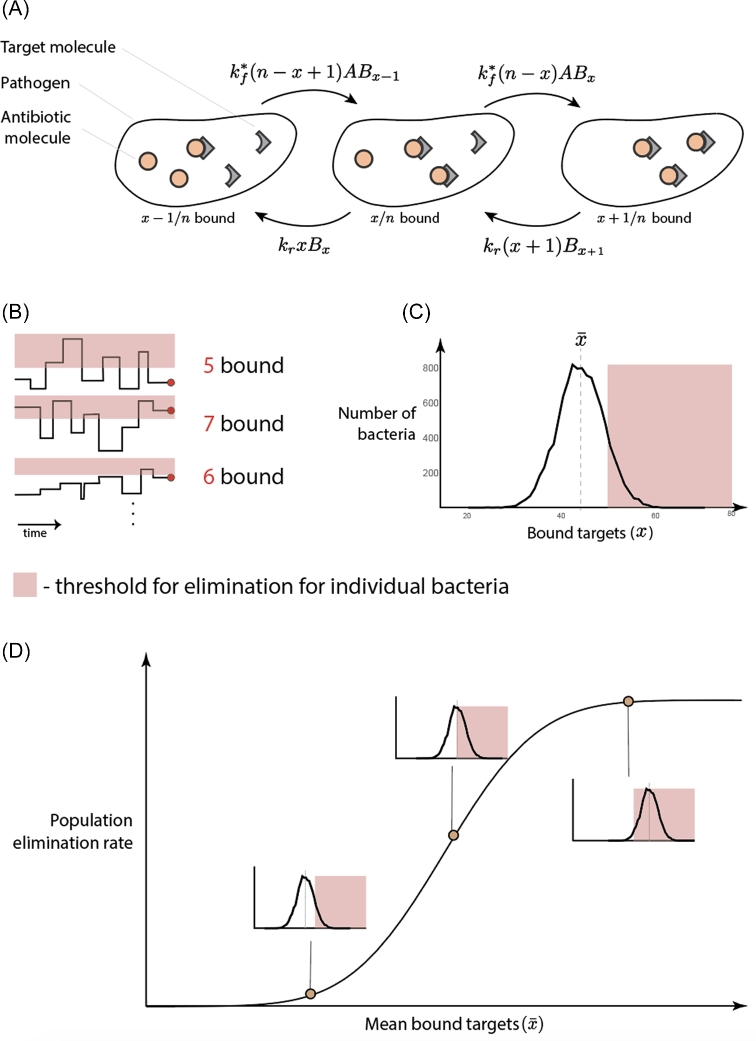
Overview of the mathematical model describing successive binding steps. A, Illustrates how the binding kinetics are calculated (Equation 1). Here, \documentclass[12pt]{minimal}
\usepackage{amsmath}
\usepackage{wasysym} 
\usepackage{amsfonts} 
\usepackage{amssymb} 
\usepackage{amsbsy}
\usepackage{upgreek}
\usepackage{mathrsfs}
\setlength{\oddsidemargin}{-69pt}
\begin{document}
}{}$k_f^*$ \end{document} is the adjusted forward reaction rate (see below), kr is the reverse reaction rate, A is the concentration of antibiotics inside the bacterium, x is the number of bound targets, n is the number of targets and Bx is the number of bacteria with x bound targets. B, Shows how the random binding and unbinding of targets causes a variance in the number of bound targets around the mean and how this causes the individual bacterium to cross the number of bound targets required for elimination. C, Gillespie simulation of Equation (1). This plot shows the distribution around the mean. The parameters used are kd = 10 − 5 (ciprofloxacin, (Spratt 1975; Terrak et al.1999)), number of targets n = 100 (gyrase, (Malmström et al.2009; Maier et al.2011)). D, Shows how the random binding and unbinding (Figure B and C) will cause a fraction of population to die earlier than expected that results in a net elimination rate. The curve on Figure D was obtained using Equation (4).